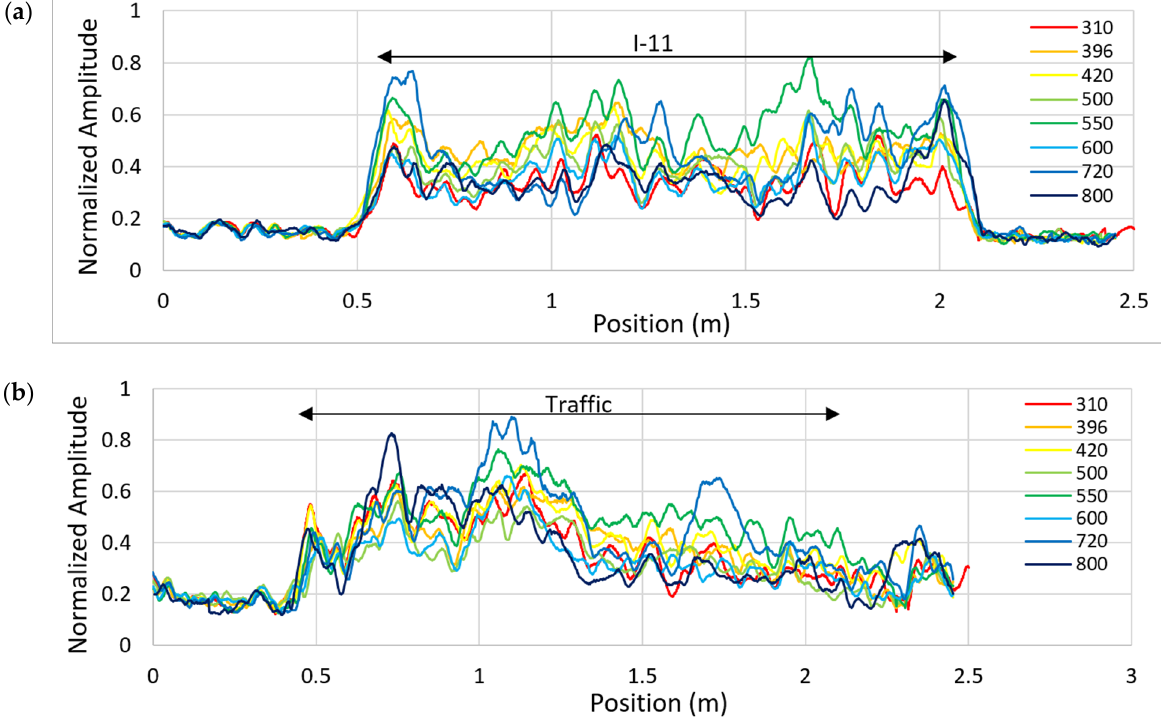
Figure 12. 2.6 GHz Norm. RW amplitudes on sand (I-11) in the ( a ) long. and ( b ) transv. direction vs. K loadings.